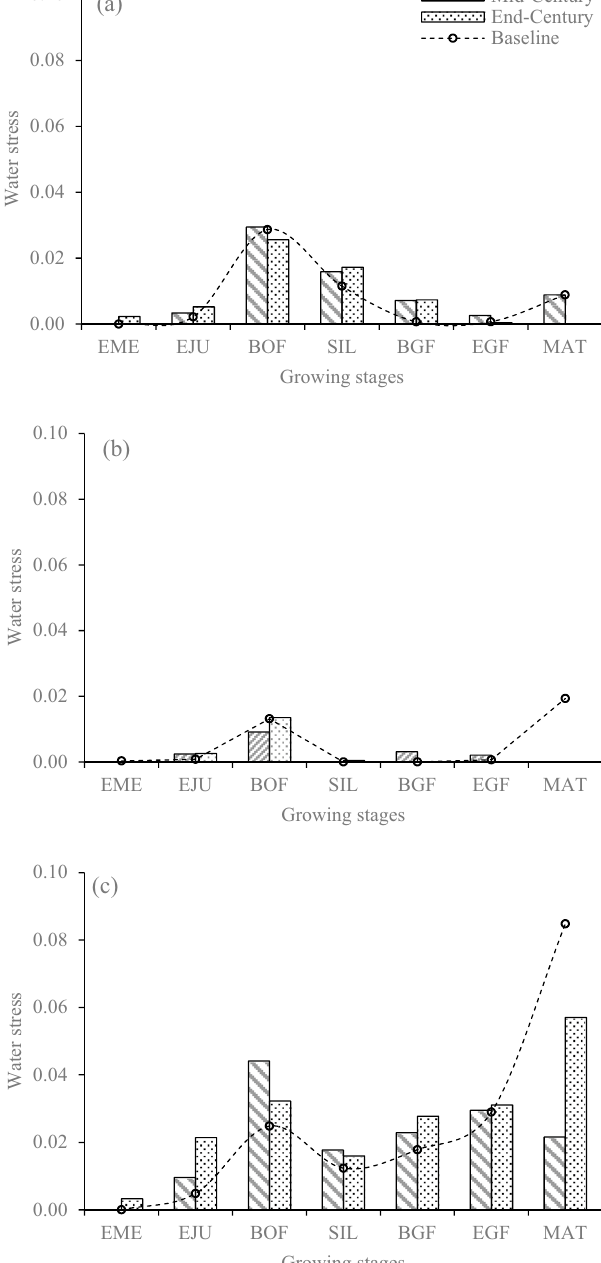
Figure 7. Comparison of baseline and future model water stress at each growing stage: Abuja in the SGS ( a ), Zaria in the NGS ( b ) and Kano in the SS ( c ) using DSSAT output. (For mid-and -end-centuries, the stresses were from four GCMs within each location). EME emergence, EJU end of juvenile, BOF beginning of flowering, SIL 75% silking, BGF beginning of grain feeling, EGF end of grain feeling and MAT